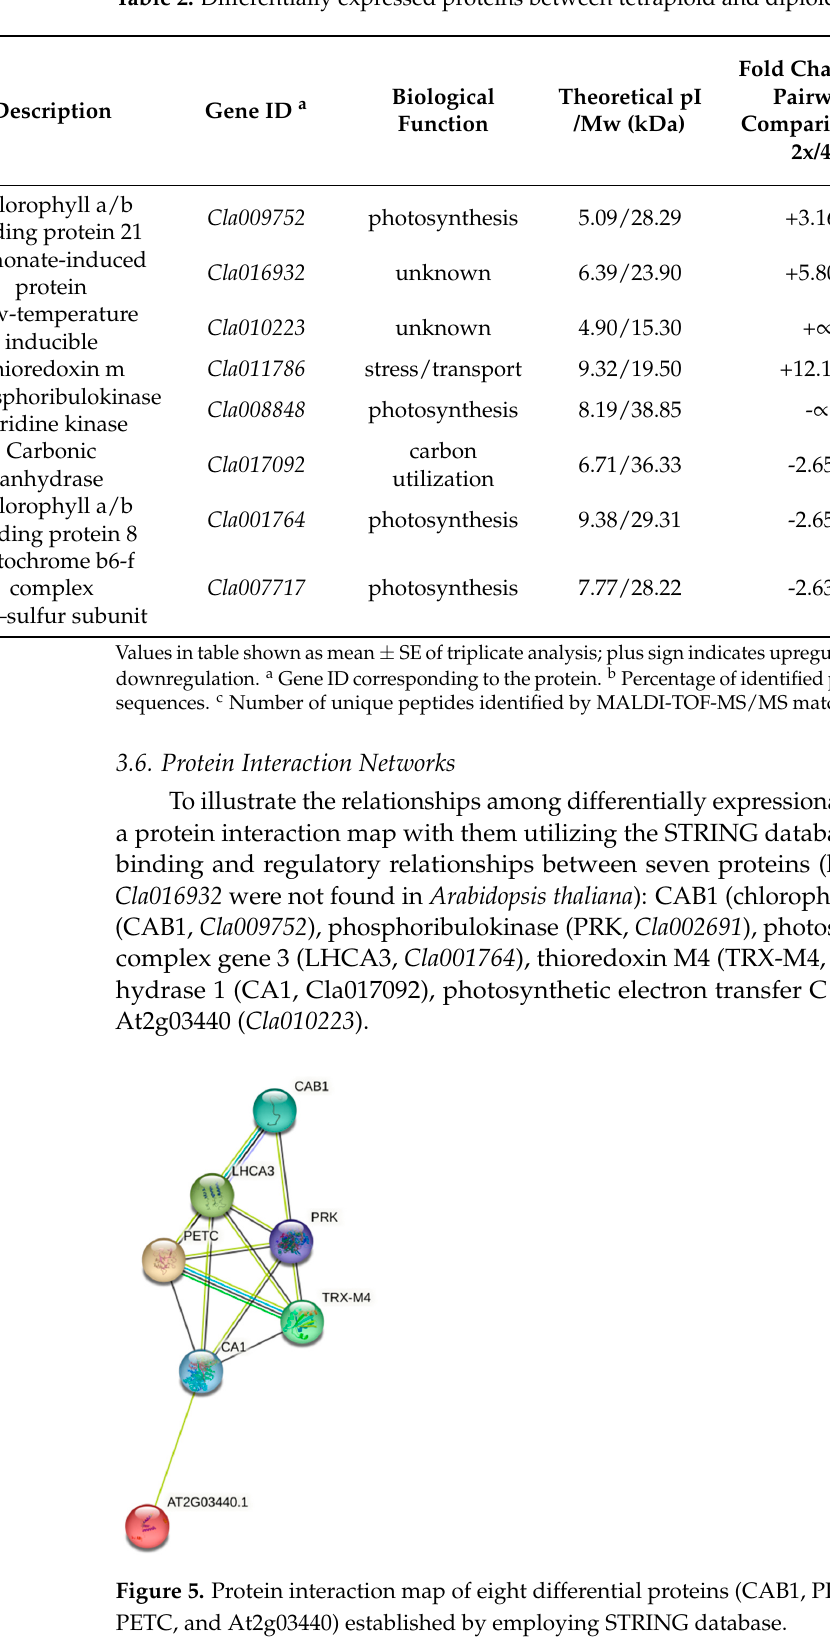
Table 2. Differentially expressed proteins between tetraploid and diploid watermelon.